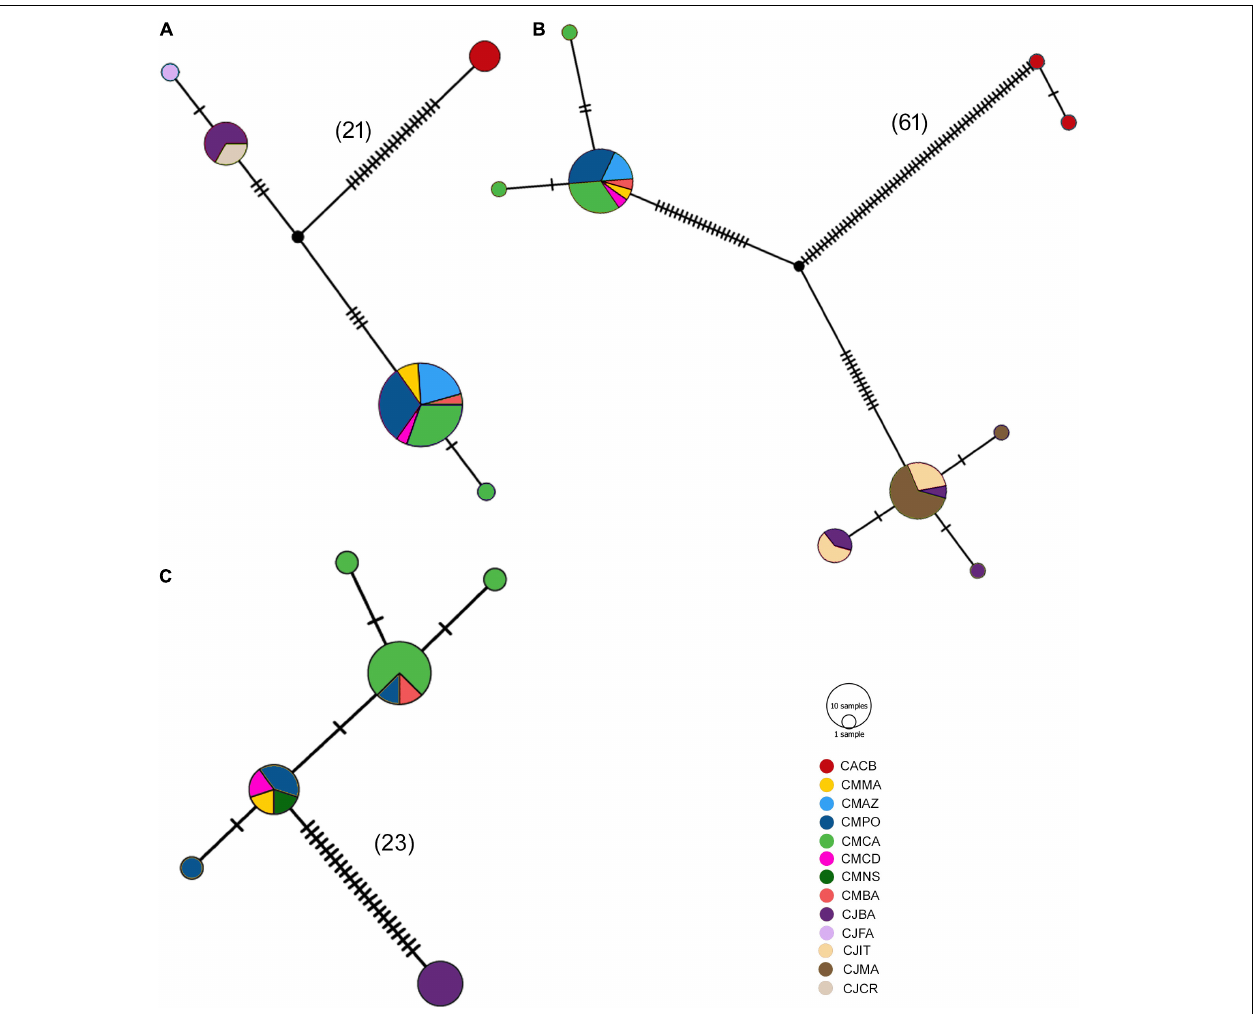
FIGURE 9 | Haplotype network for each fragment: (A) 12S, (B) COI, and (C) CYTB. Nomenclature: CACB, Coris atlantica Cape Verde; CMMA, Coris melanura Madeira; CMAZ, C. melanura Azores; CMPO, C. melanura Portugal; CMCA, C. melanura Cantabria Sea; CMNS, C. melanura North Sea; CMBA, C. melanura Balearic Islands; CJBA; Coris julis Balearic Islands; CJFA; C. julis France; CJIT, C. julis Italy; CJMA, C. julis Malta; CJCR, C. julis Crete. Mutation steps are indicated as diagonal bars, and steps larger than 20 are also indicated in